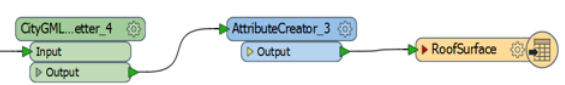
Figure 8: Algorithm of semantic mapping of RoofSurface